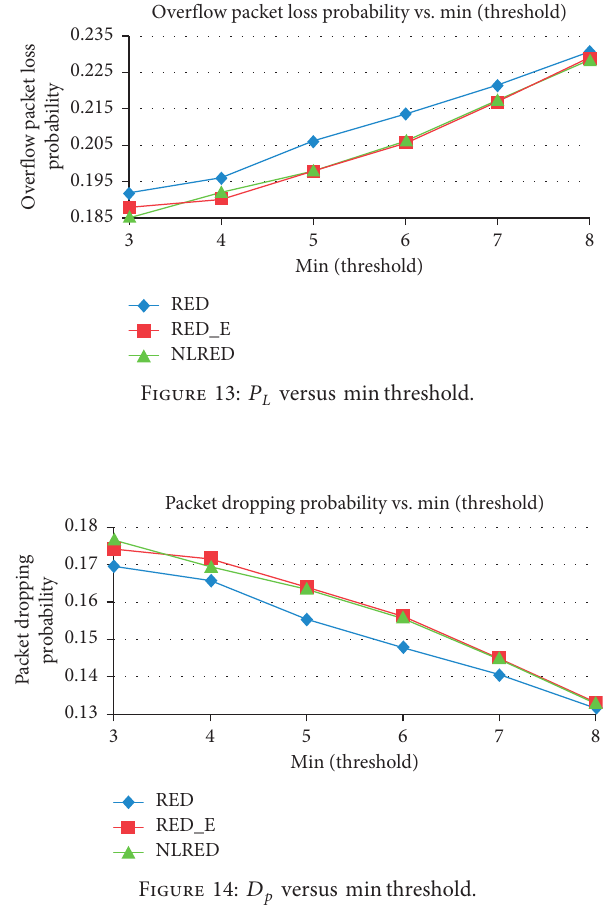
Figure 14: D p versus min threshold.